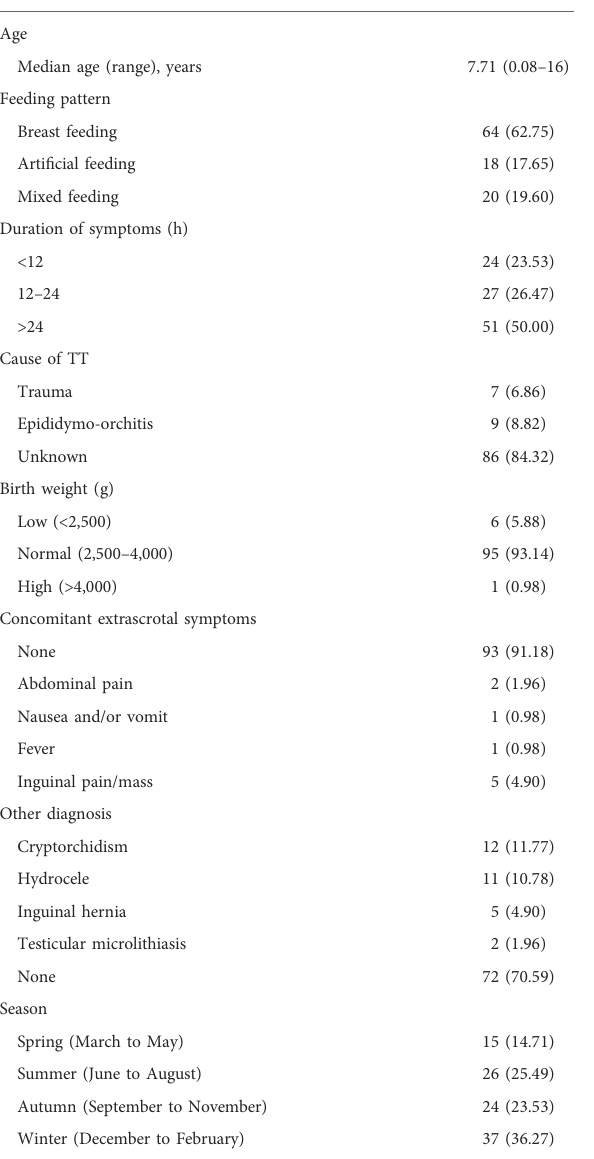
TABLE 1 Details of patients with TT.